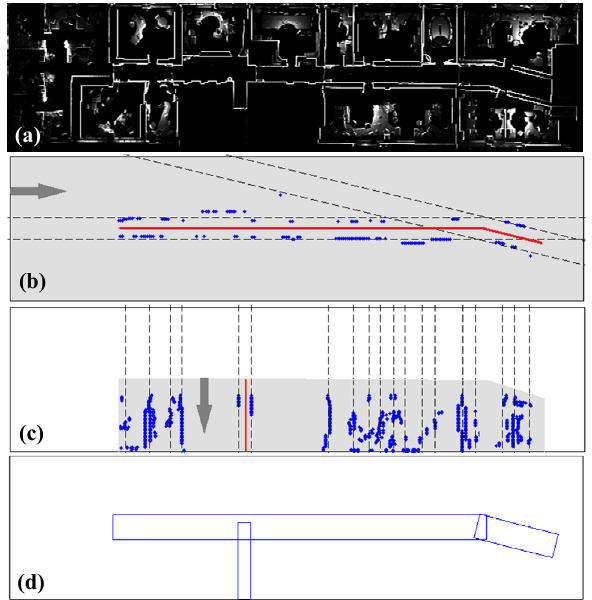
Figure 2. Derivation of 2D hallway polygons from an exemplary 3D point